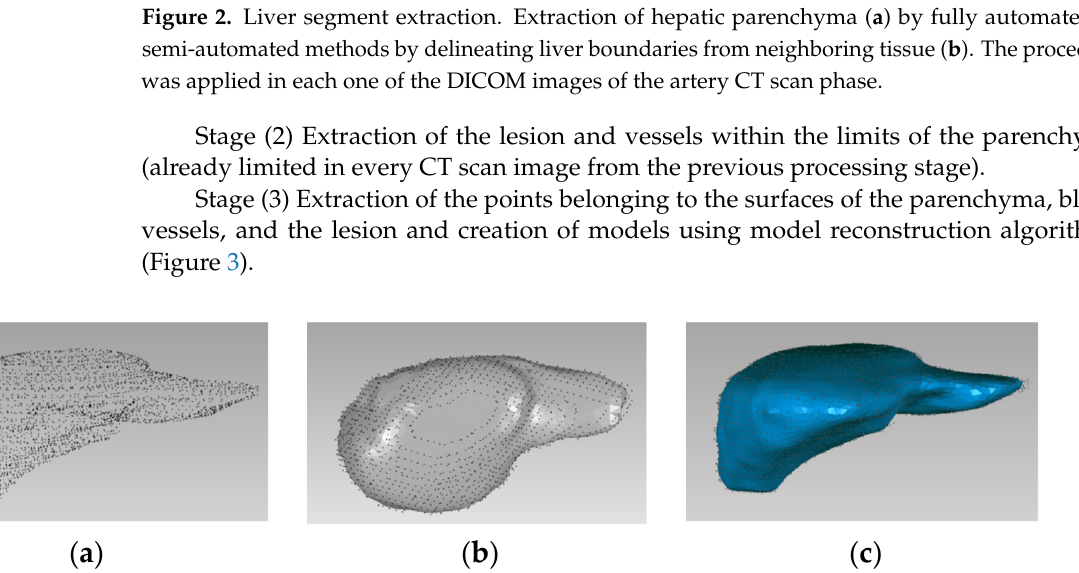
Figure 3. Point cloud and surface models of a patients’ liver. Points extracted on the outer surface of the liver segment in every DICOM image of a CT scan generated the complete point cloud ( a ) leading to the top view ( b ) and front view ( c ) presentation of the parenchyma.